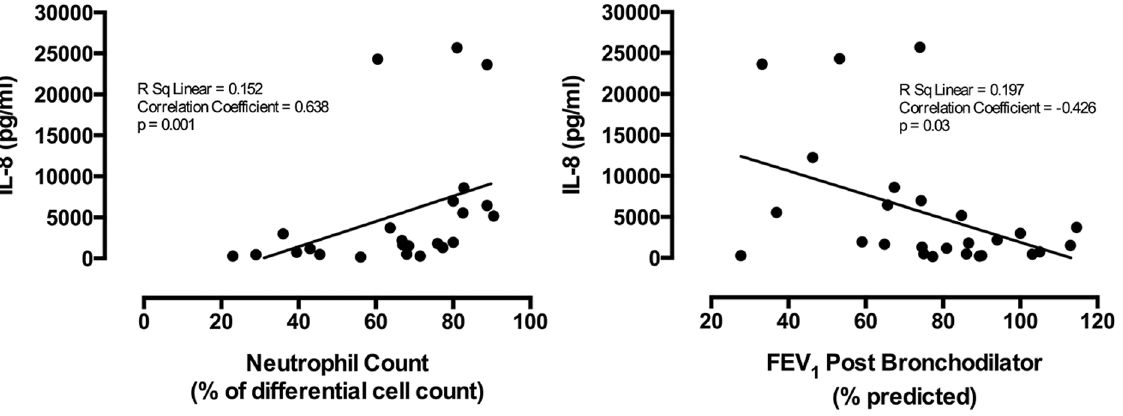
Figure 2. Interleukin-8 sputum supernatant concentrations in severe asthma related to sputum neutrophil count and lung function. The relationship in treatment-resistant severe asthma between IL-8 concentrations in induced sputum and (A) neutrophil differential cell counts and (B) Post bronchodilator percent predicted FEV 1 .